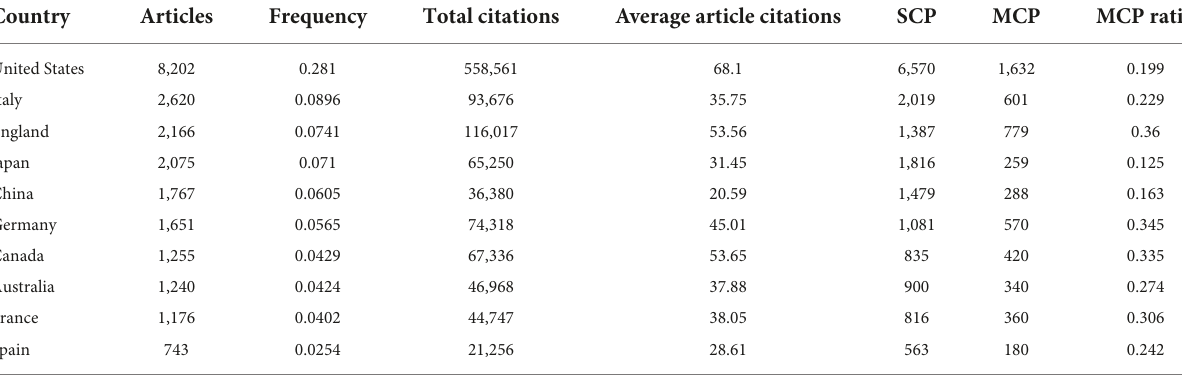
TABLE 2 Overview of top 10 countries with the highest number of publications.